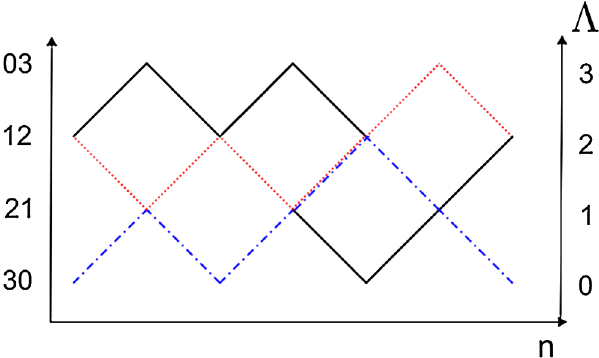
FIG. 11. Bratteli diagram of the k ¼ 3 Read-Rezayi state with two possible paths indicated. The red dashed line corresponds to the sector label 12 11 2 11 2 11 2 1120 3 02 12 and the blue dot-dashed line corresponds to the sector label 3 02 1 20 3 0211 2 1120 30